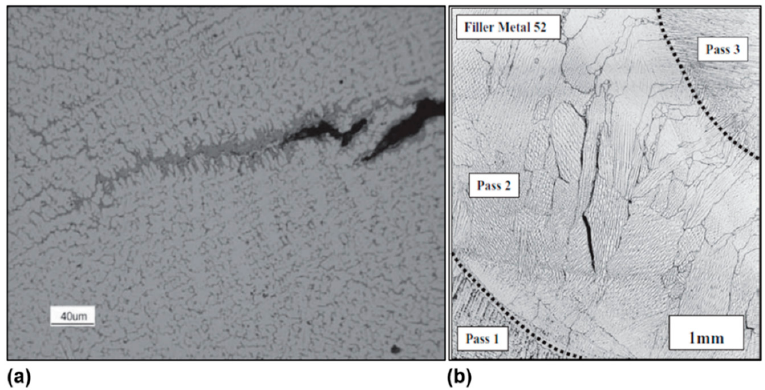
Figure 14. ( a ) Solidification crack: the crack path and eutectic constituents are coexisting. The eutectic constituent forms from the terminal solute-rich liquid at the end of solidification. ( b ) Ductility-dip cracking (DDC) in multipass welding